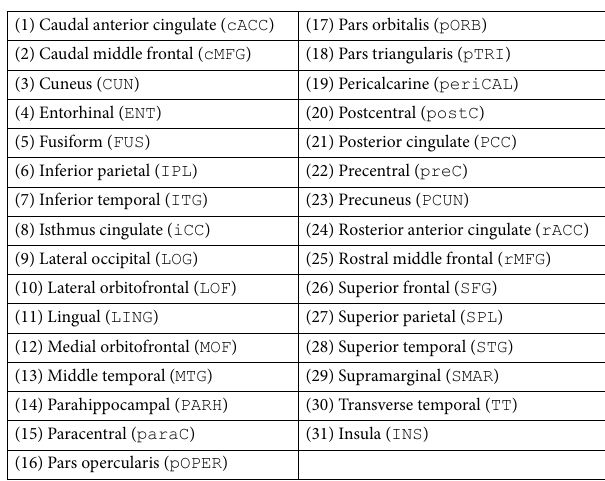
Table 2. The 31 cortical labels (per hemisphere) of the Desikan–Killiany–Tourville atlas. The ROI abbreviations from the R brainGraph package are given in parentheses and used in later